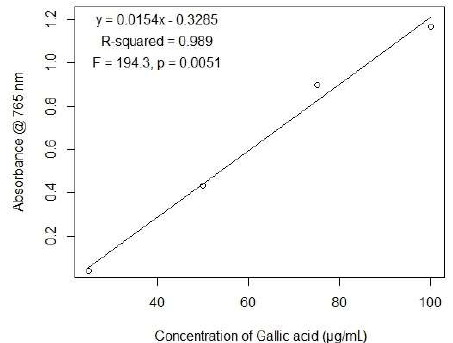
Figure 1. Calibration curve of gallic acid obtained from the linear model.